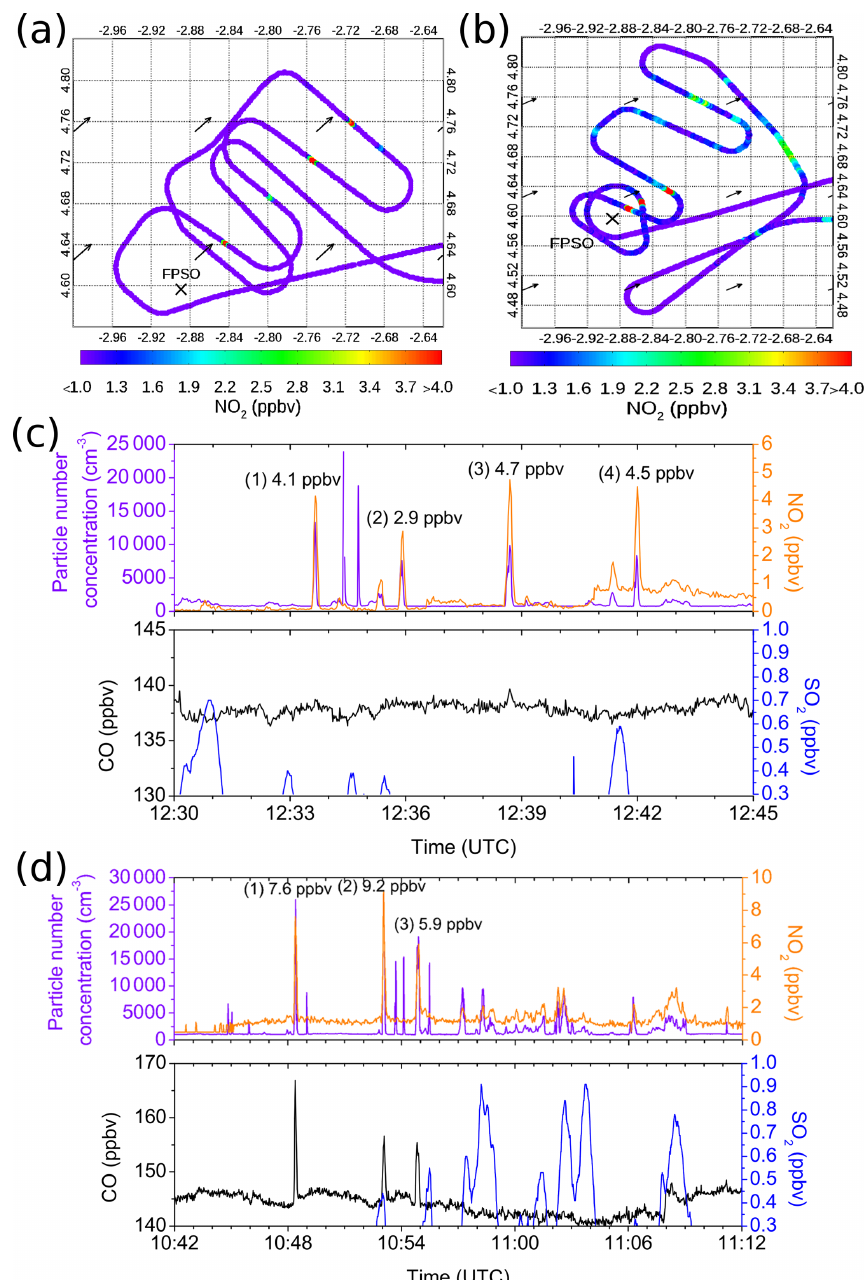
Figure 1. (a) NO 2 concentration as a function of the flight trajectory downwind of the FPSO plume for 10 July. The black arrows show the wind direction (from ECMWF). (c) NO 2 , aerosol, CO and SO 2 concentrations as a function of time, restricted in a part of the flight trajectory in (a) . The peaks studied are labelled by a number (from 1 to 4). (b) and (d) are similar to (a) and (c) for 14 July.